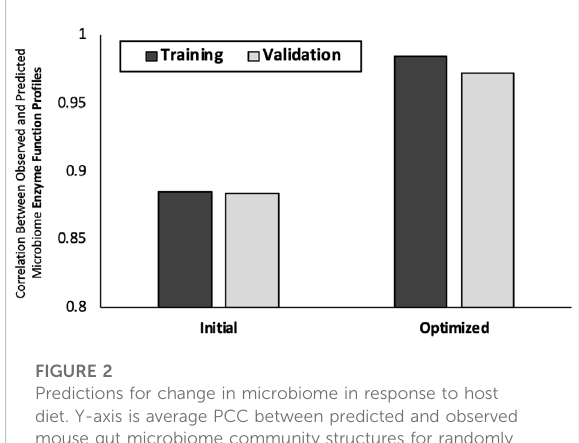
FIGURE 1 A community interaction network for mouse microbiome communities. This fi gure shows the result from the MAP-model. Diamonds are diet parameters, amino acids are blue, carbohydrates are yellow, fats are green, minerals are purple, and vitamins are orange. Circles are bacterial taxa and the size of bacterialnodeisproportionatetotheiraveragerelativeabundance across all analyzed microbiomes. Solid lines indicate interaction between taxa at fi nal time point, dashed line indicate interactions between taxa at time initial and fi nal time point.